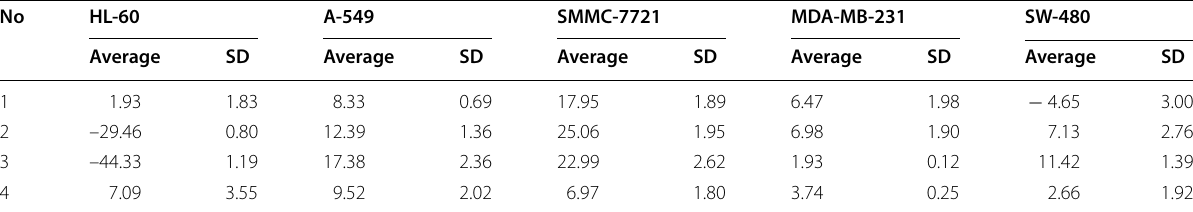
Table 3 Cytotoxicity of compounds 1 – 4 against five human tumor cell lines, cell inhibition